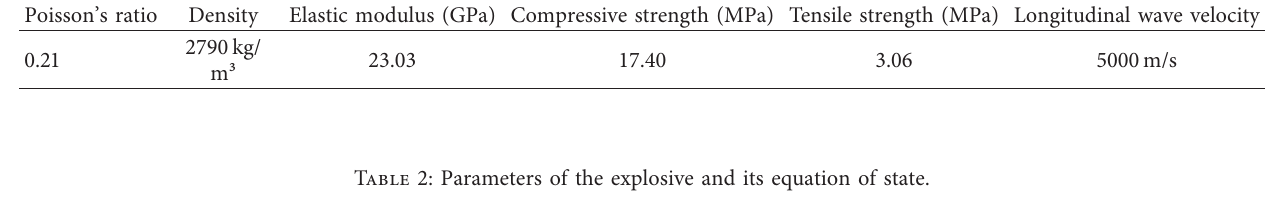
Table 1: Quartz rock mechanical parameters [26].